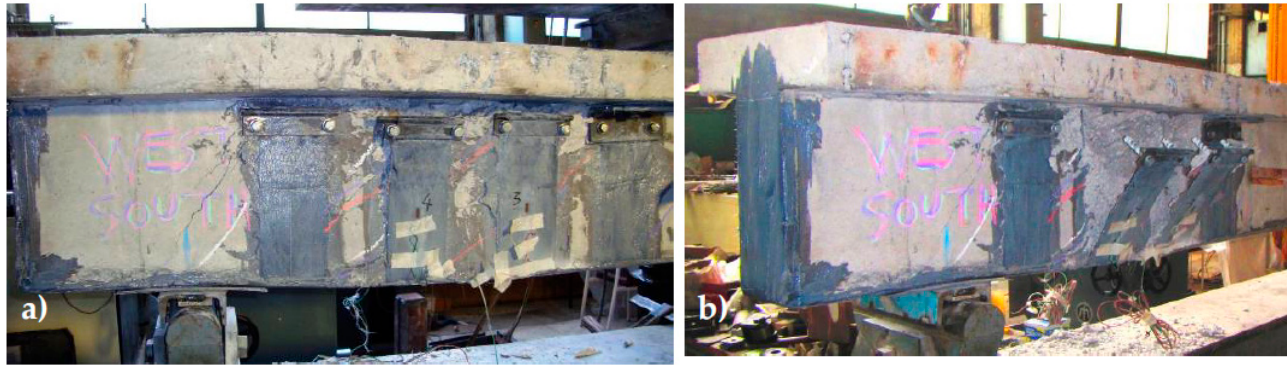
Figure 22. Comparison of the measured response between the prototype RC Virgin T-beam, this T-beam having been retrofitted with the 1 st , 2nd, and 3rd st rengthening schemes . ( a ) Shear force versus the deflection at mid-span. ( b ) Bending moment versus the deflection at mid-span.